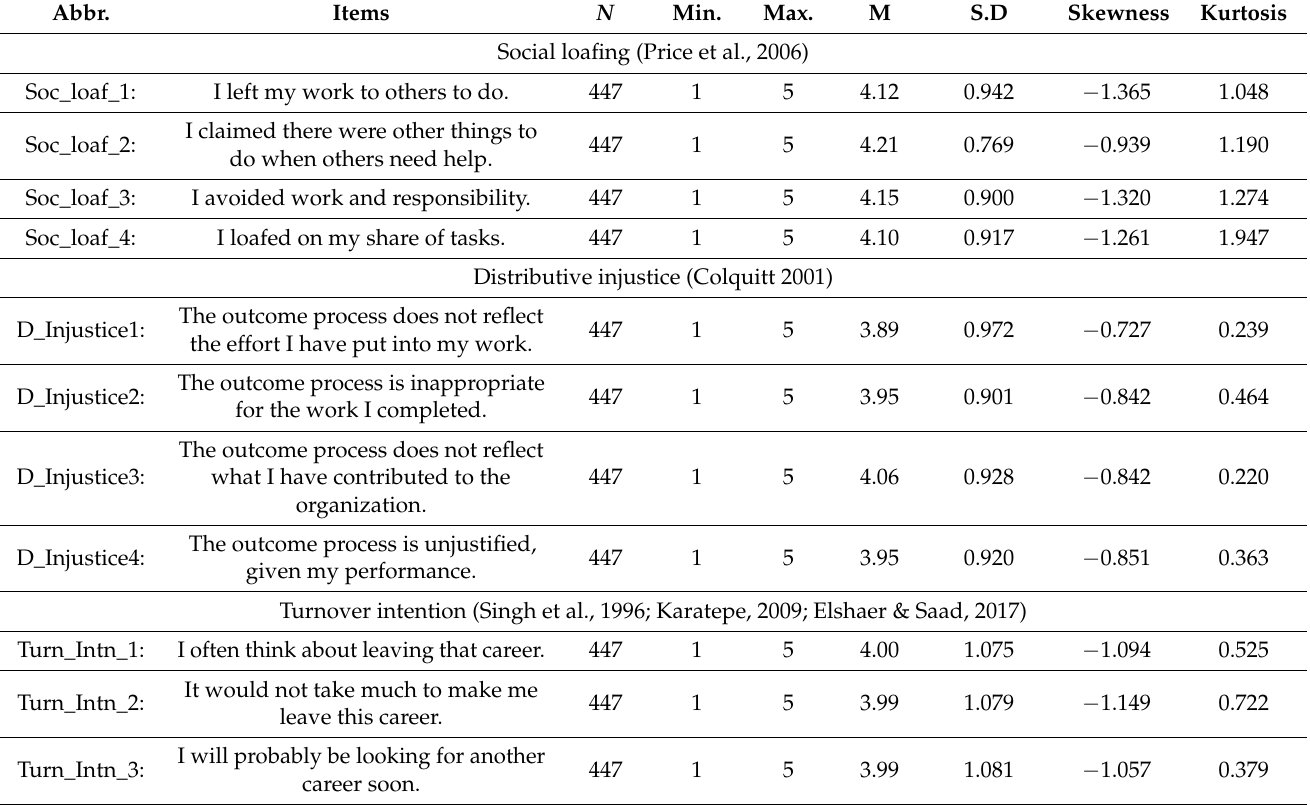
Table 1. Descriptive